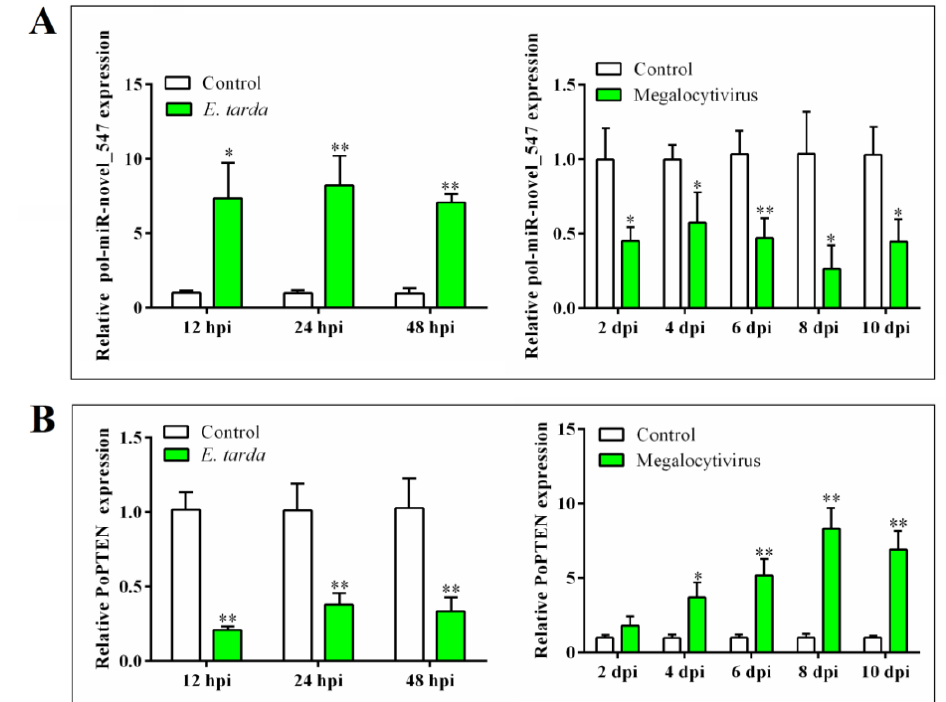
Figure 1. Expression of pol–miR-novel_547 ( A ) and phosphatase and tensin (PTEN) homolog of flounder (PoPTEN) ( B ) in response to bacterial and viral infection. Flounder were infected with or without (control) Edwardsiella tarda or megalocytivirus, and the expressions of pol–miR-novel_547 ( A ) and PoPTEN ( B ) in kidney were determined by quantitative real time RT-PCR at different times. hpi, hour post-infection; dpi, day post-infection. Values are the means of triplicate experiments and shown as means ± SD. * p < 0.05; ** p < 0.01.